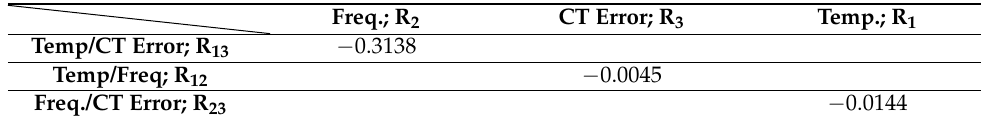
Table 6. Matrix of partial correlation–influence on connection.